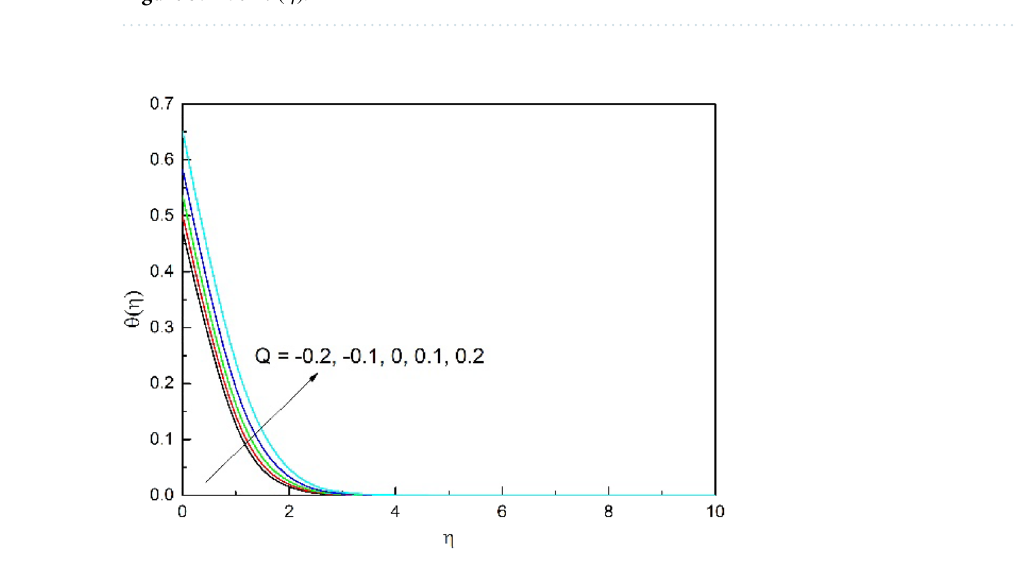
Figure 3. R on θ(η) .